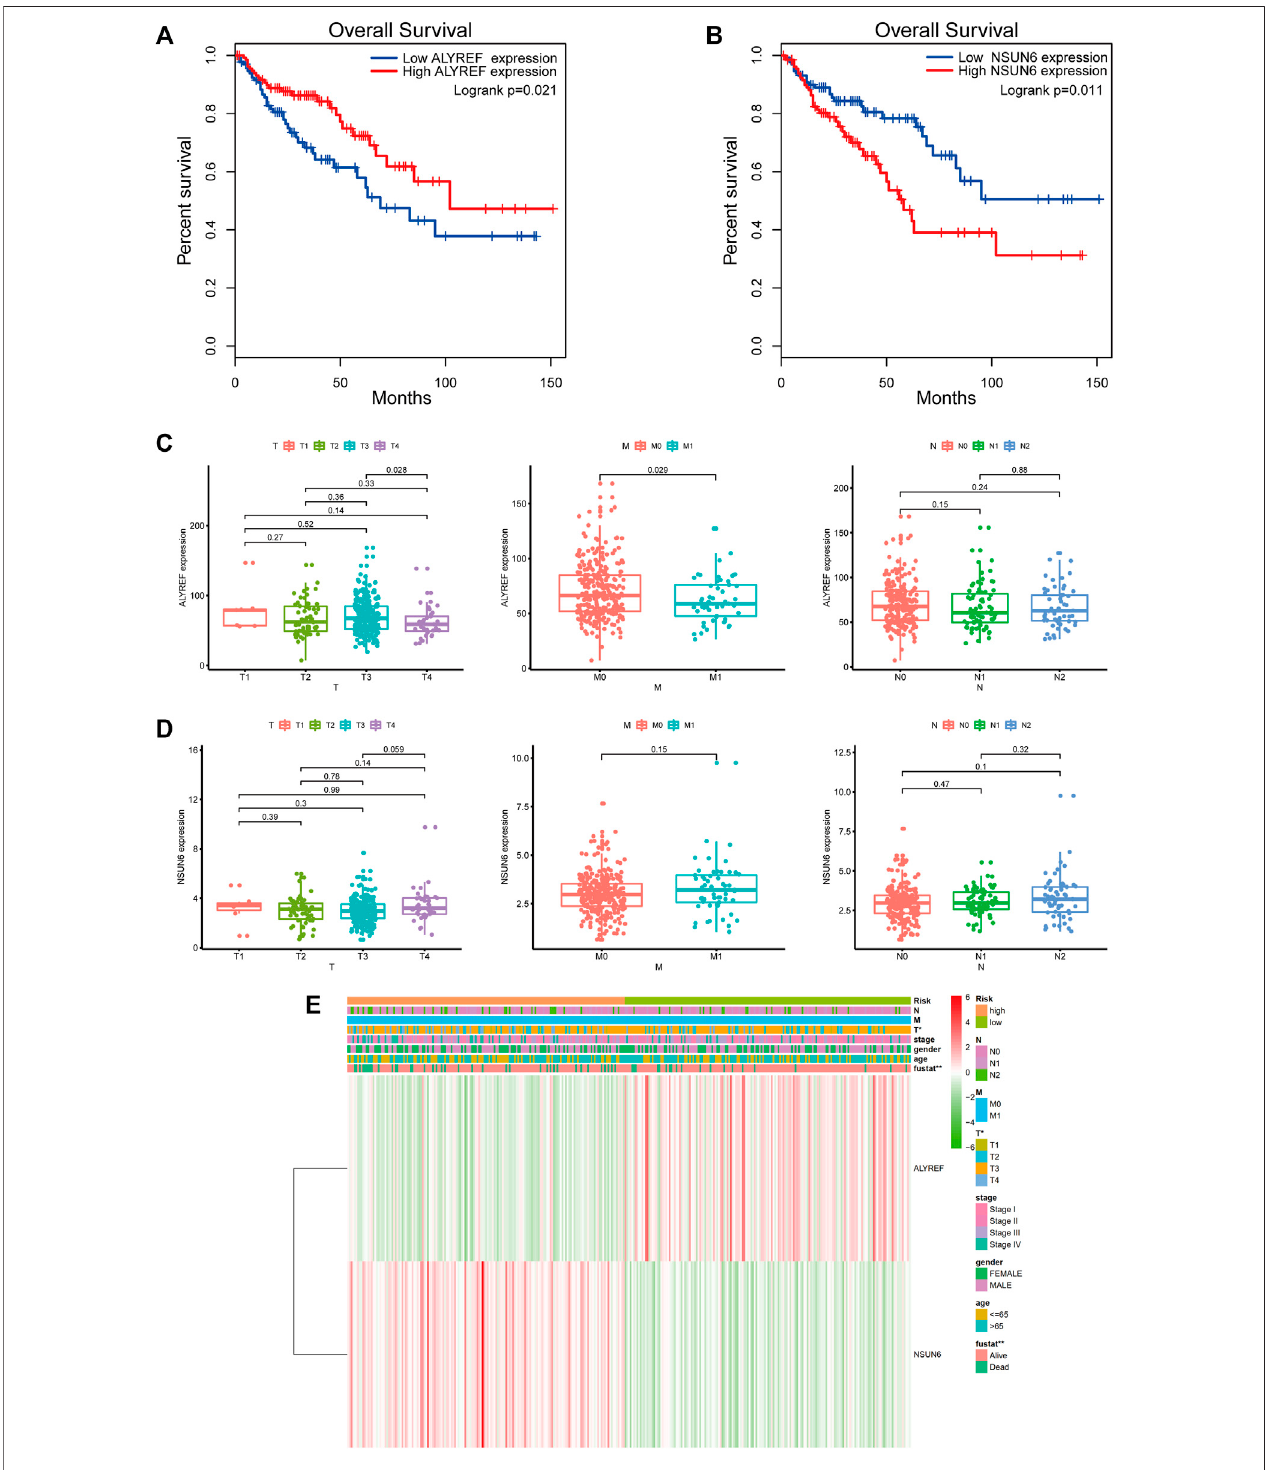
FIGURE8| Survivalanalysisandclinicopathologicalcharacteristics ofthetwom 5 C-relatedregulators. (A) Kaplan-MeiersurvivalcurveofALYREF inhigh-andlow- expression groups. (B) Kaplan-Meier survival curve of NSUN6 in high- and low-expression groups. (C) Analysis of the relationship between the expression of ALYREF and TMN stage. (D) Analysis of the relationship between the expression of NSUN6 and TMN stage. (E) The heatmap shows the expression of NSUN6 and ALYRE in high-risk and low-risk. The distribution of clinicopathological characteristics was compared between the high-risk and low-risk groups. * p < 0.05, ** p < 0.01.